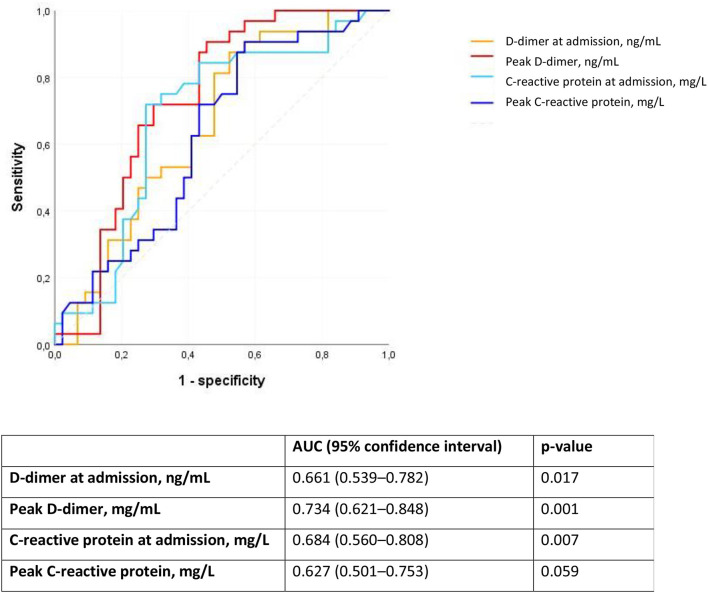
Receiver operating characteristic (ROC) curve for D-dimer and C-reactive protein as predictors of pulmonary embolism in patients with Covid-19. AUC, area under the ROC curve.